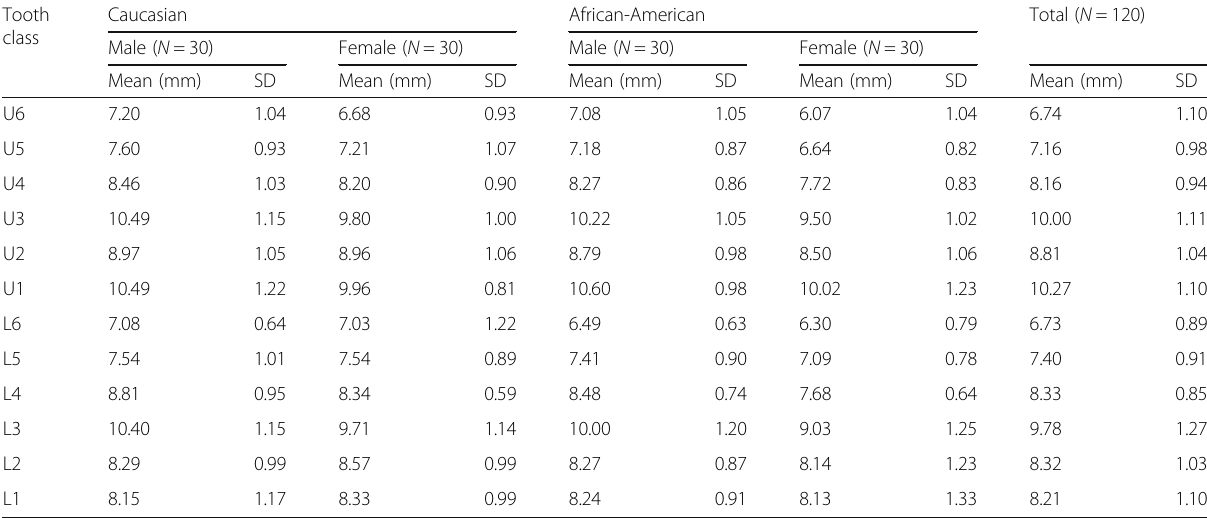
Table 1 Clinical crown height means ± SD for the subgroups Tooth class